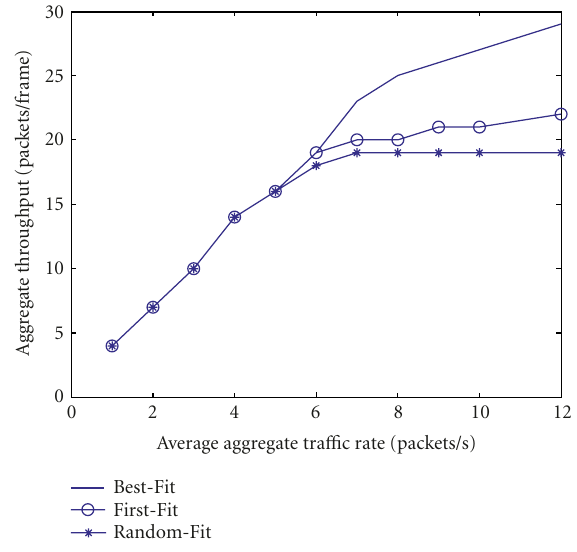
Figure 4: Capacity comparison among basic